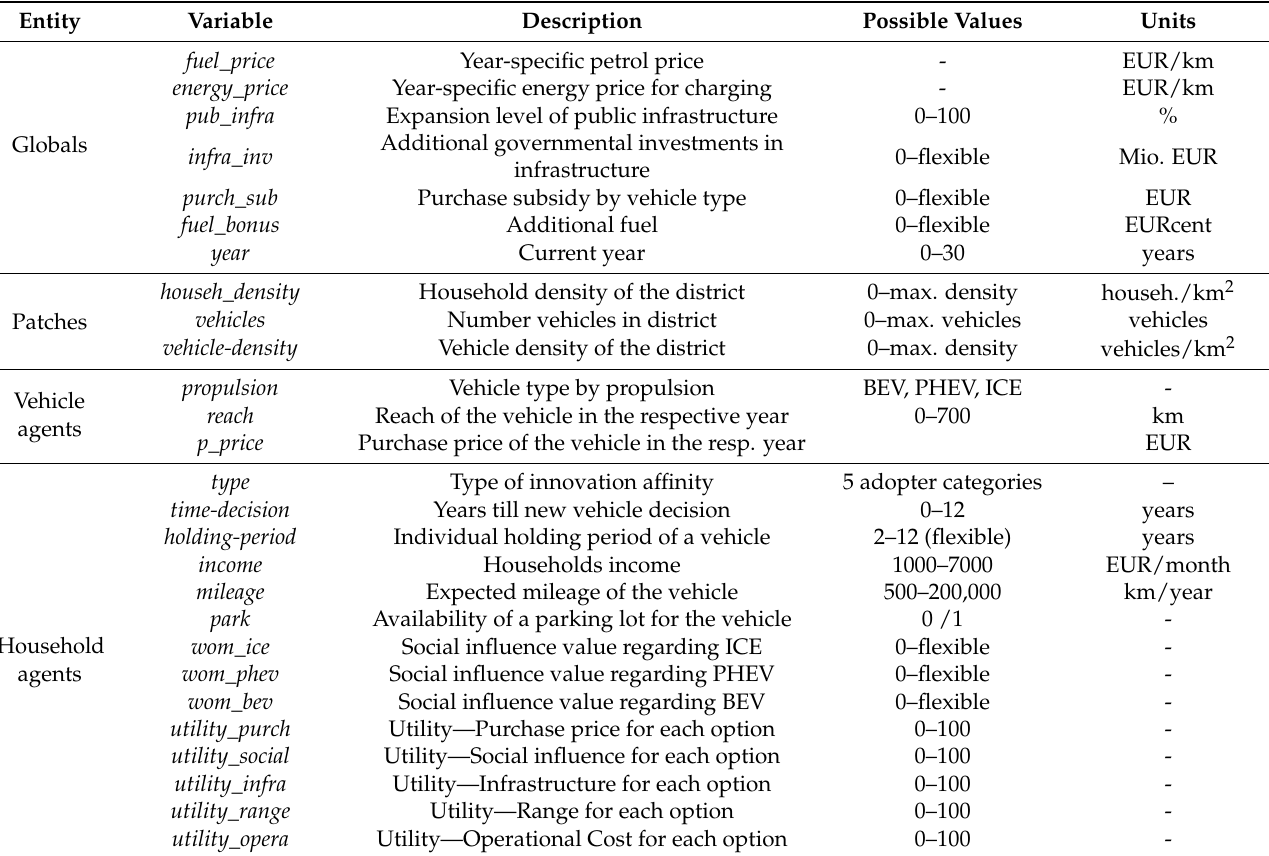
Table 1. Table of